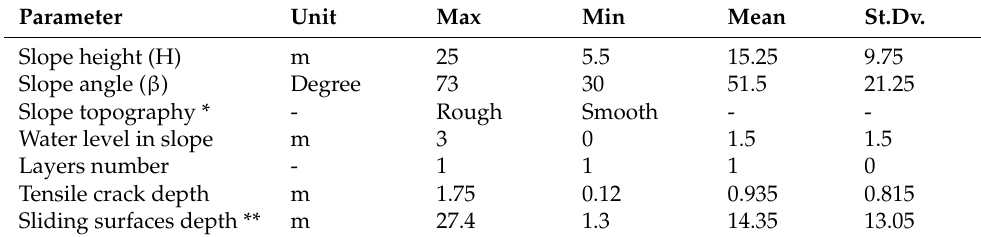
Table 2. Studied slopes’ geometrical properties.